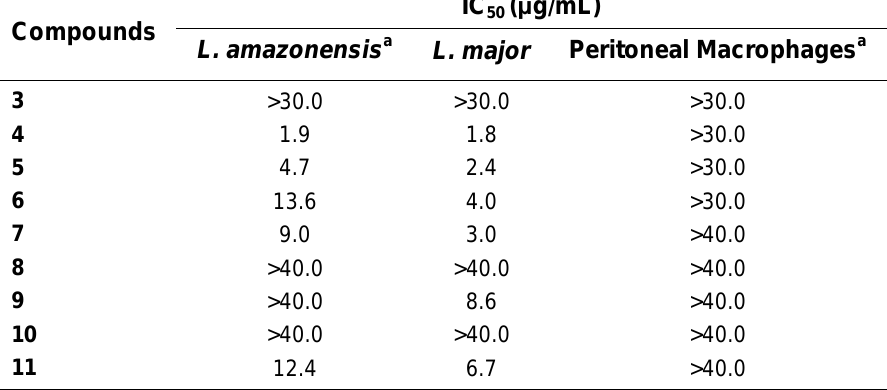
Effect of the Compounds 3 – 11 against L. amazonensis and L.